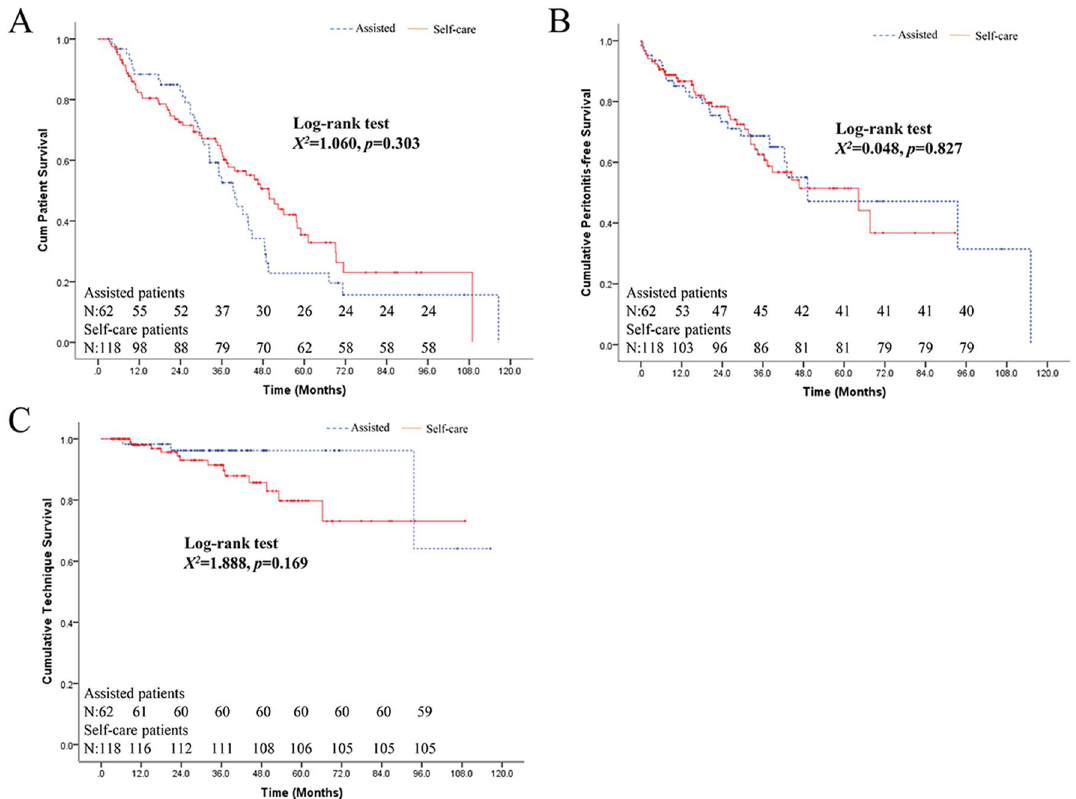
Figure 2. Kaplan–Meier curves by assistance for patient survival ( A ), peritonitis-free survival ( B ) and technique survival ( C ).